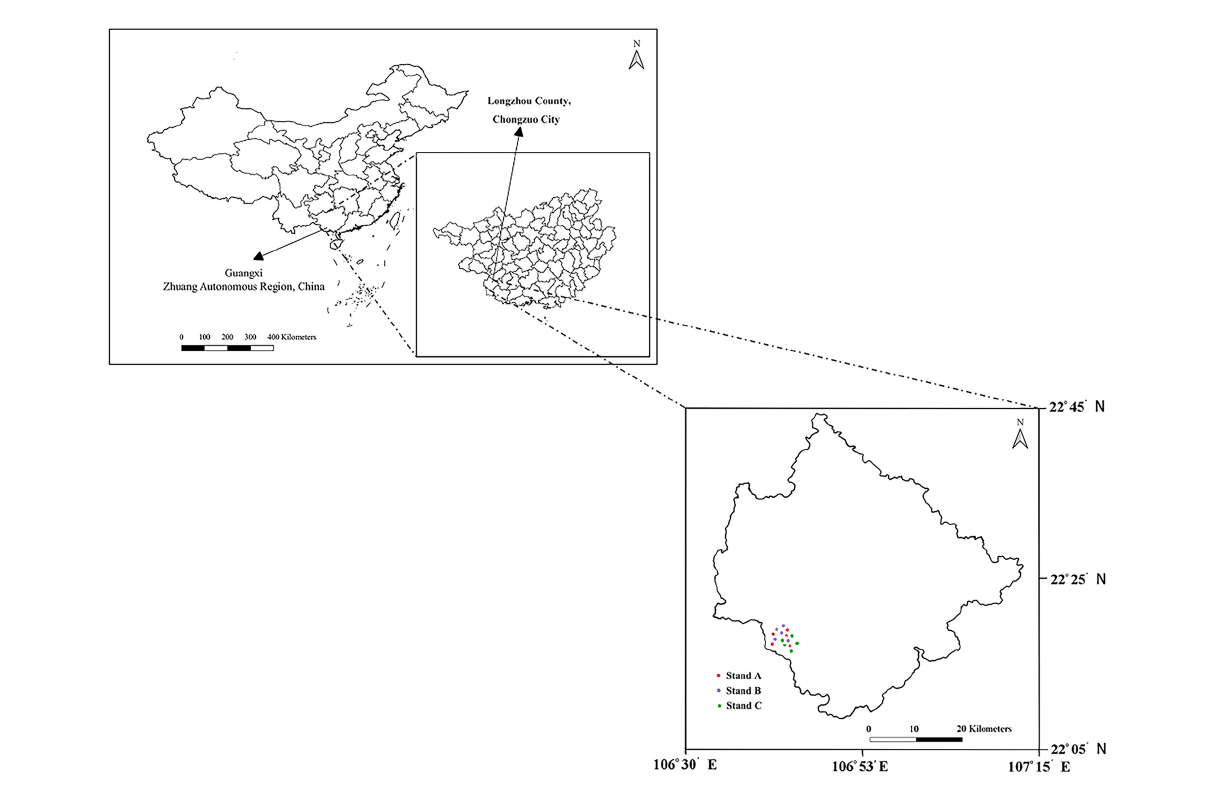
TABLE 1 Basic information of sample plots in Chinese fir plantations with different stand types.